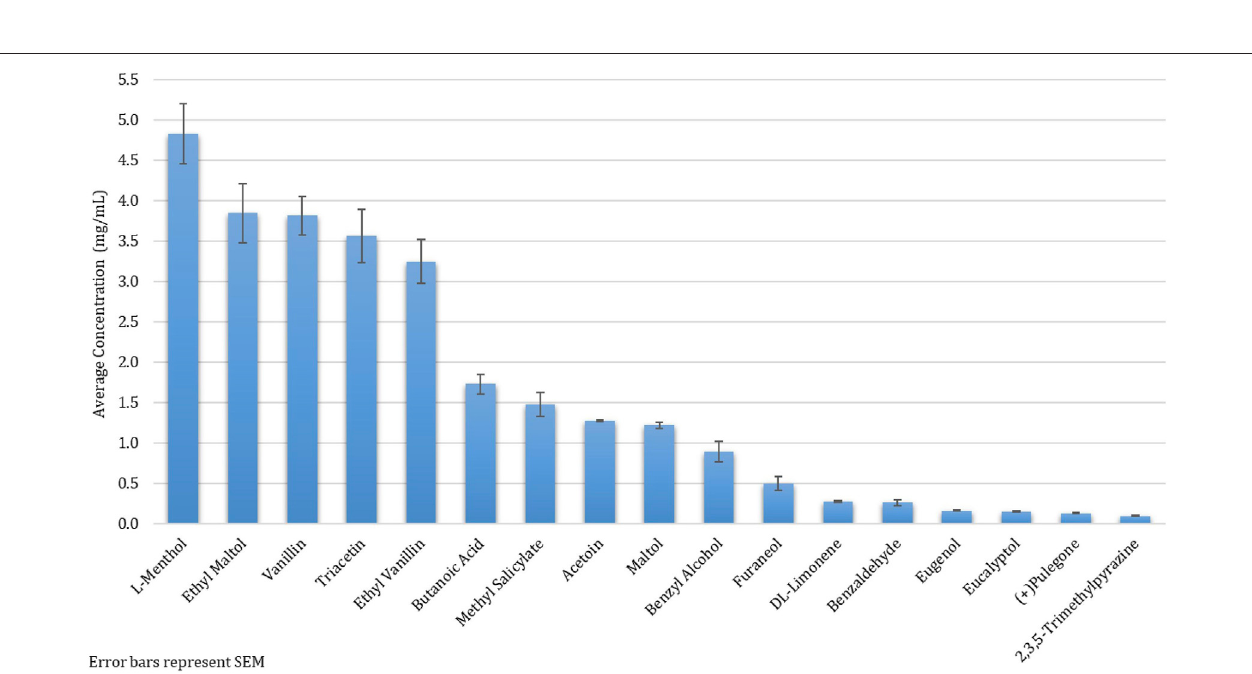
Frontiers in Chemistry |